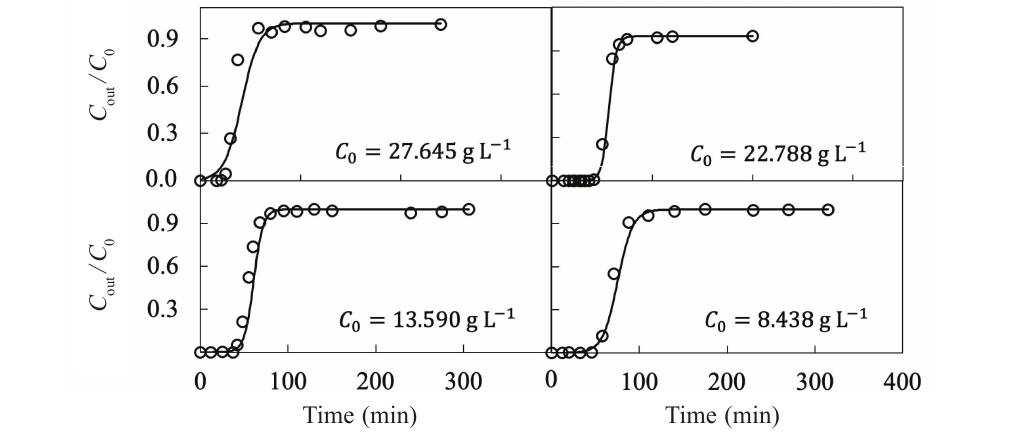
Fig. 3 – Breakthrough curves at different concentrations